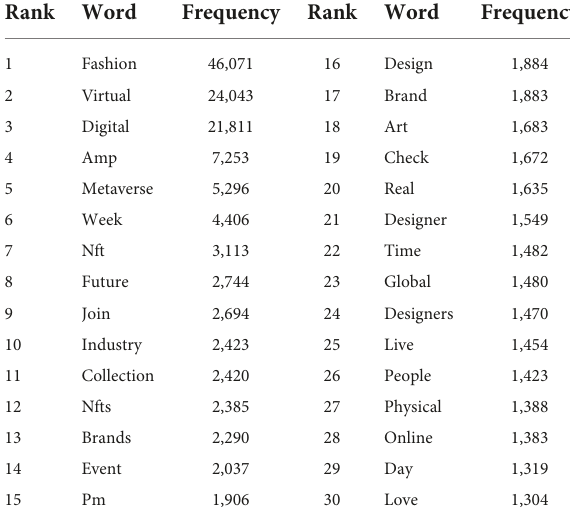
TABLE 3 Results of the word frequency analysis.